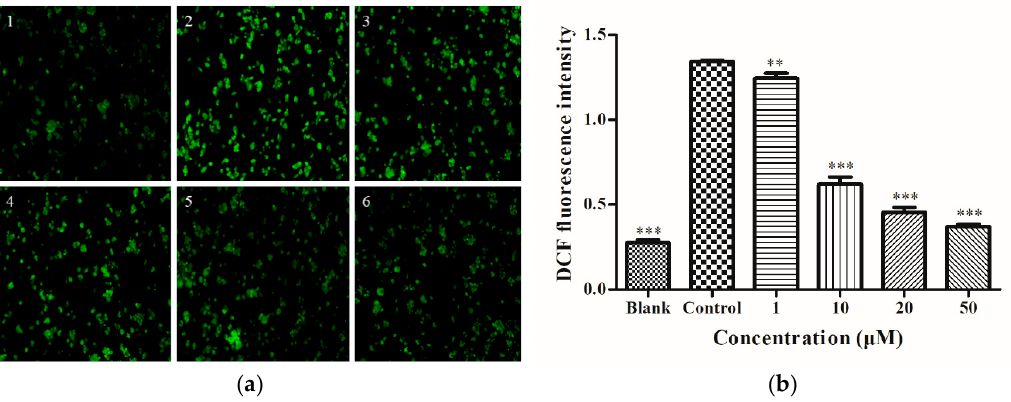
Figure 2. ( a ) Effect of DIF on intracellular reactive oxygen species (ROS) level. (1) HepG2 cells without treatment (the blank group); (2) cells exposed to 0.5 M ethanol (the control group); (3)–(6) cells pretreated with DIF (1, 10, 20, and 50 μ M) for 2 h and then treated with 0.5 M ethanol for 24 h. ( b ) The relative DCF fluorescence intensity. Data are shown as mean ± SD (n = 3). ** Compared with the control group, p < 0.01. *** Compared with the control group, p < 0.001.